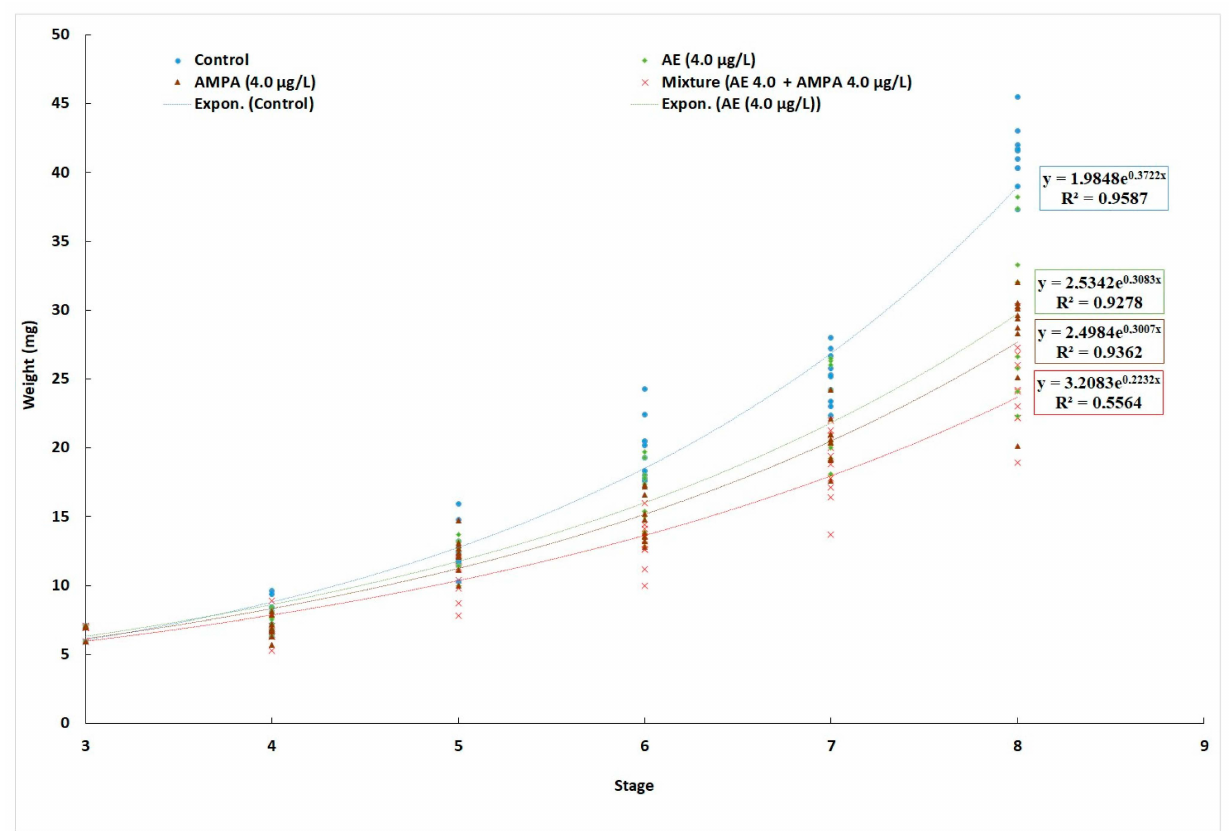
Figure 1. Body weight of early life stages of marbled crayfish Procambarus virginalis during 50-day exposure to acetochlor ESA (AE; 4.0 µ g/L; N = 31), aminomethylphosphonic acid (AMPA; 4.0 µ g/L; N = 32) and their combination (AE; 4.0 µ g/L + AMPA; 4.0 µ g/L; N = 29) and in control (no exposure, N =